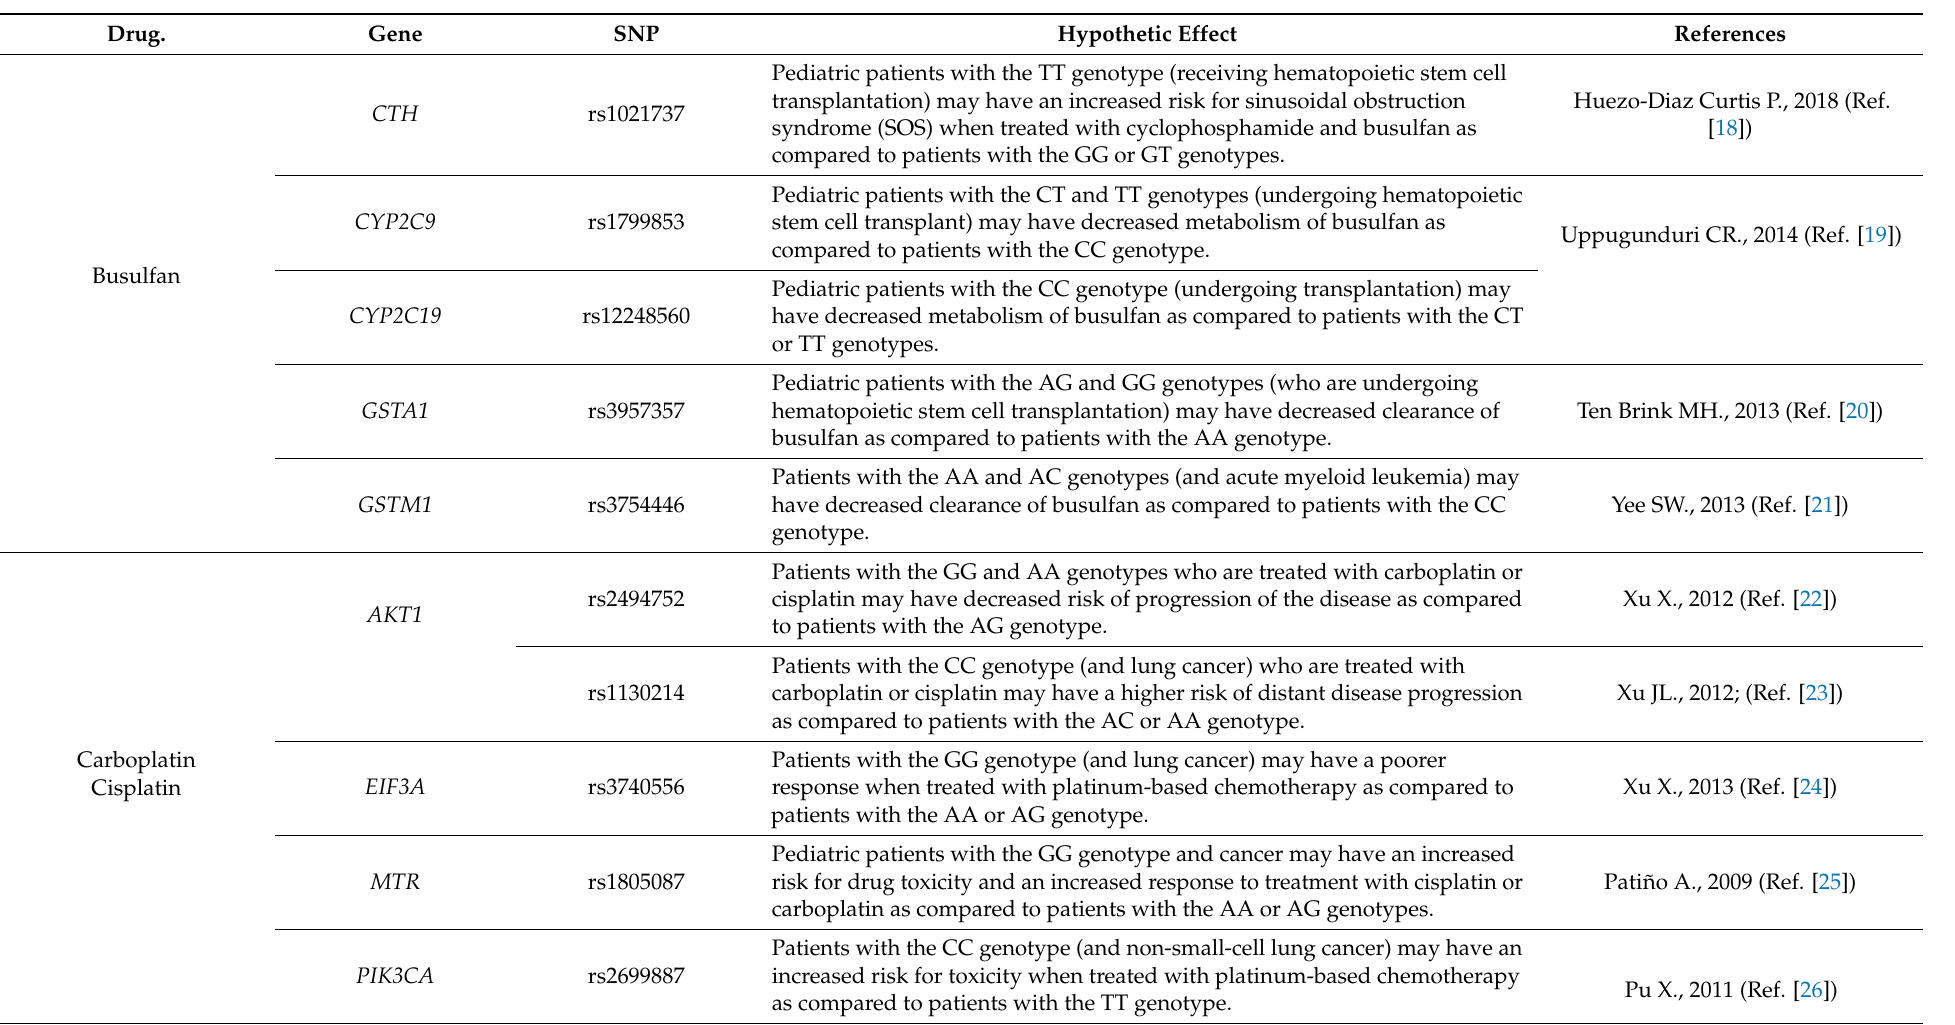
Table 3. Candidate SNPs and genes to evaluate regarding the efficacy and toxicity of the drugs in Neuroblastoma (based in PharmGKB and the included references).